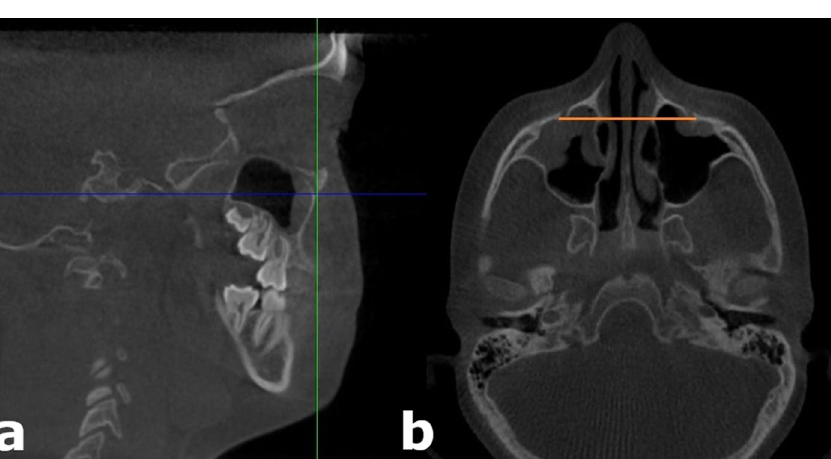
Figure 4. Measurement of the linear distance between the lateral margins of the infraorbital foramina (IOFd). ( a ) Sagittal view, ( b ) Axial